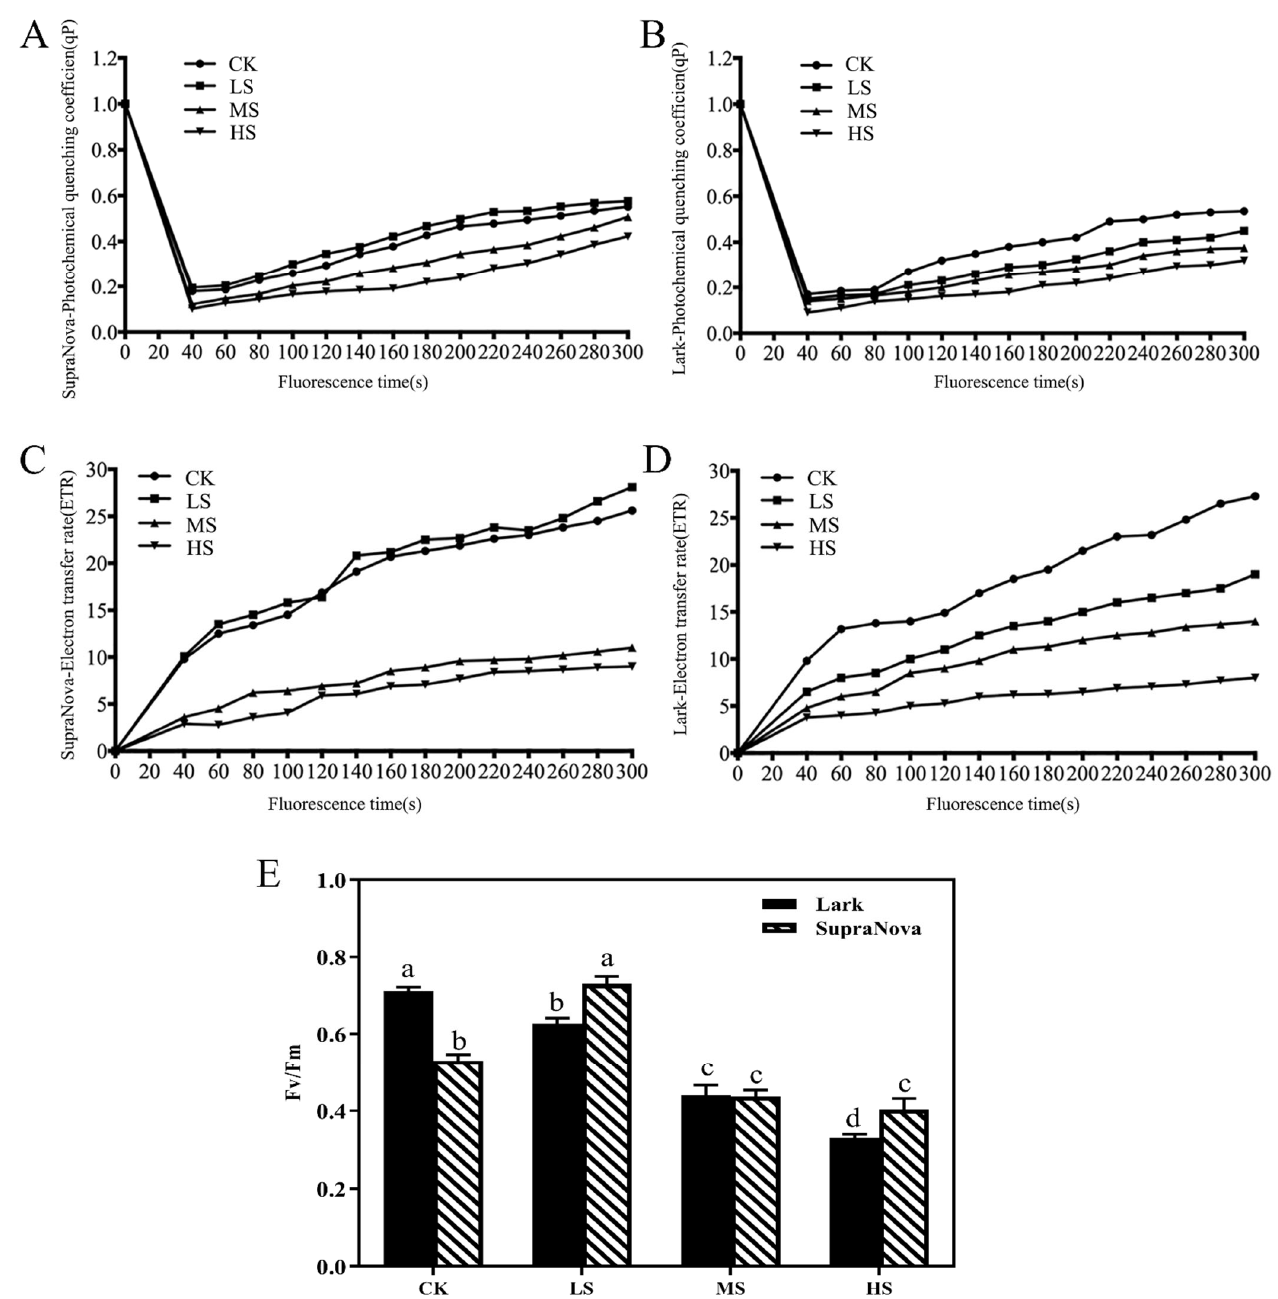
Figure 2. Changes in chlorophyll fluorescence of two turfgrass species. Notes: ( A , B ) correspond to the qP of two turfgrass species; ( C , D ) correspond to the ETR of the two turfgrass species; and ( E ) corresponds to the Fv/Fm value of the two turfgrass species. The lowercase letters denote significant differences ( p < 0.05) for the same species. The total number of replicates used for this experiment was four. CK = unshaded; LS = 35% shaded; MS = 70% shaded; HS = 92% shaded.